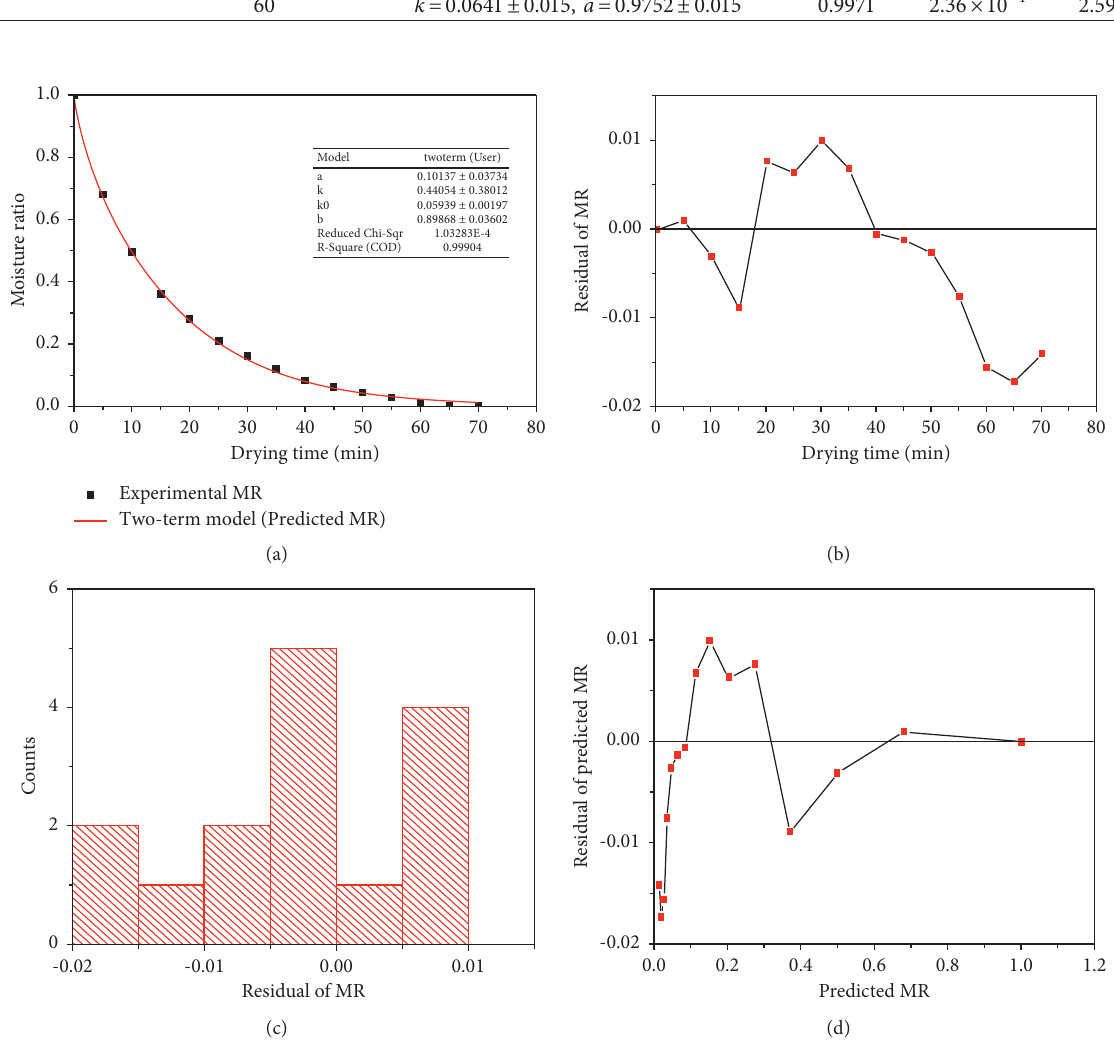
Figure 3: (a) Two-term model fitting plot. (b) Variation of residuals with time. (c) Normal probability plot of residuals. (d) Hetero- scedasticity